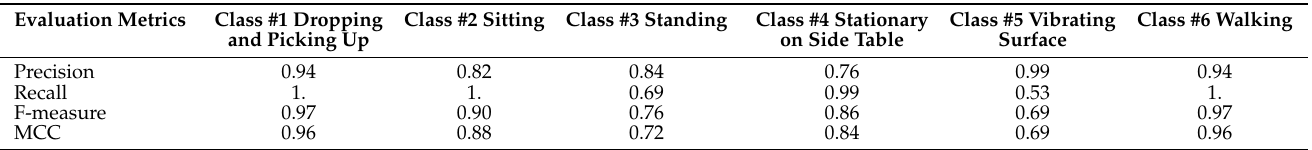
Table 3. Precision, Recall, F -measure, and MCC for fuzzy